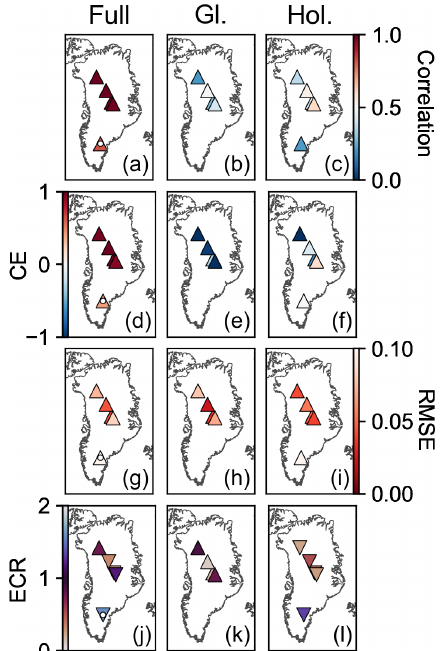
Figure 7. Skill metrics averaged over iterations and time for the precipitation reanalysis. The first column (a, d, g, j) shows the skill metrics for the full overlap (Full) between the proxy record and reanalysis. A white dot indicates evaluation against proxy records that overlap only the Holocene (11.7–0ka). The middle col- umn (b, e, h, k) shows the skill metrics for a period in the glacial (Gl.) (20–15ka), while the right column (c, f, i, l) is for a period in the Holocene (Hol.) (8–3ka). The first row (a–c) reports the corre- lation coefficient, the second row (d–f) the coefficient of efficiency (CE), the third (g–i) the root mean square error (RMSE), and the fourth row (j–l) the ensemble calibration ratio (ECR). Triangle sym- bols pointing up indicate that the posterior ensemble evaluates bet- ter than the prior ensemble for that location and statistic. Triangle symbols pointing down indicate the opposite. We define better eval- uation as correlation coefficient closer to 1, CE closer to 1, RMSE closer to 0, and ECR closer to 1.